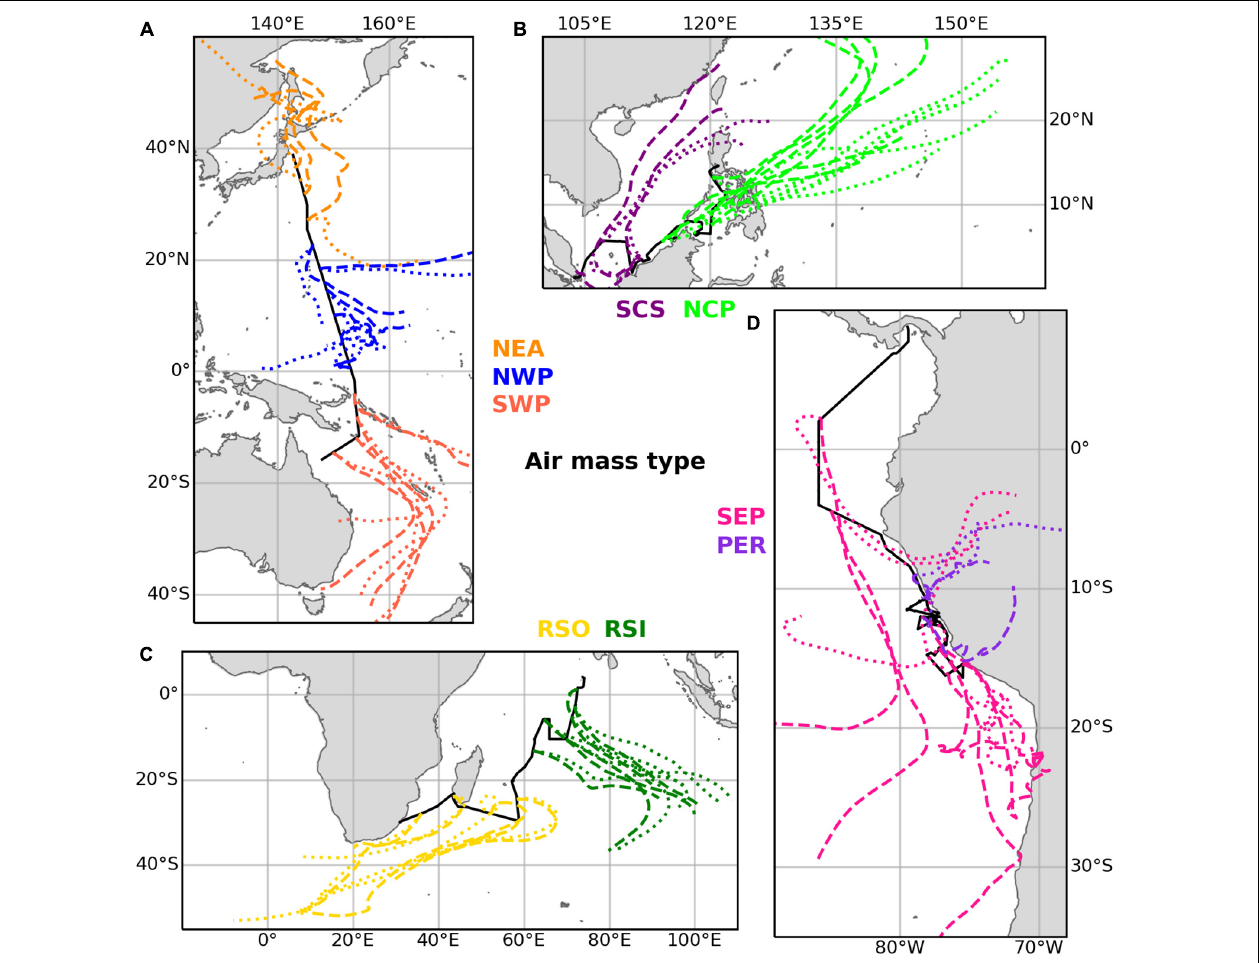
FIGURE 2 | Examples illustrating the trajectories of the main air mass types found in the datasets for (A) TransBrom, (B) SHIVA, (C) OASIS, and (D) M138. Dashed lines show trajectories for arrival heights of 10 m above the ships’ positions. Dotted lines are for arrivals at 1,000 m. Examples of type EPP (M138) are not shown, as this classification was a mixture of the SEP and PER